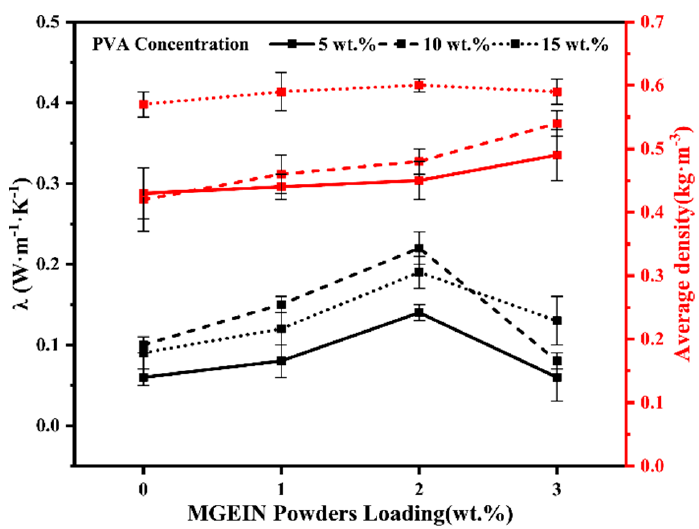
Figure 7. Thermal conductivity of Gr/PVA impregnated modified veneers.